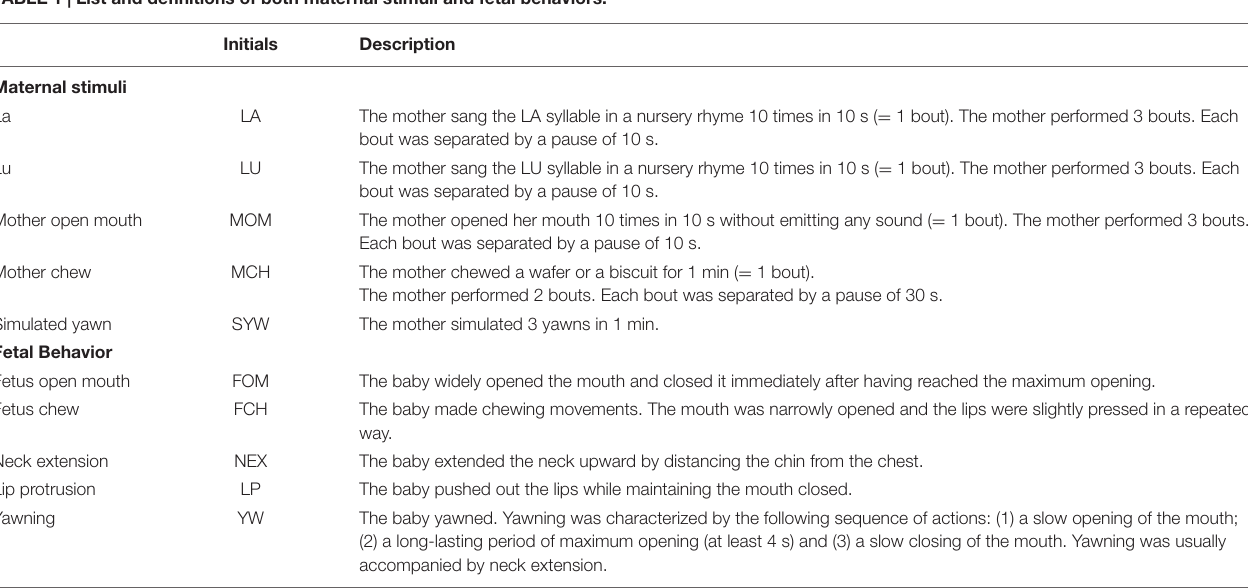
FIGURE 1 | An ultrasonographic image and the experimental setting. The small frame shows the mother and ecographer, together with the operator (AFG) and the father. (a) Shows the mother while opening the mouth and (b) shows the fetus’ congruent response of mother’s mouth opening. TABLE 1 | List and definitions of both maternal stimuli and fetal